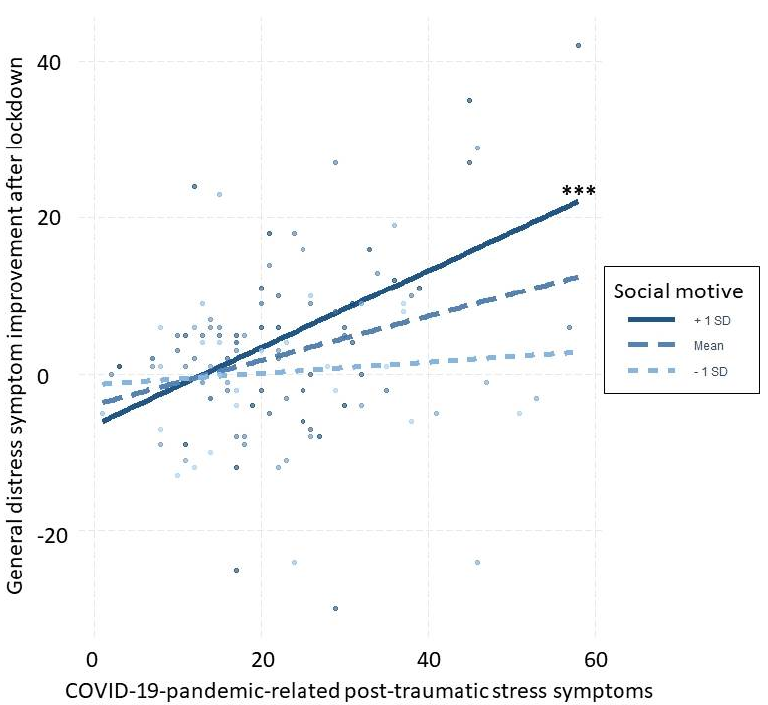
Figure 1. Moderation of using SM for social motives on the relationship between improvement of general distress symptoms after lockdown and COVID-19-pandemic-related post-traumatic stress symptoms. *** statistically significantly different slopes ( p value < 0.001).